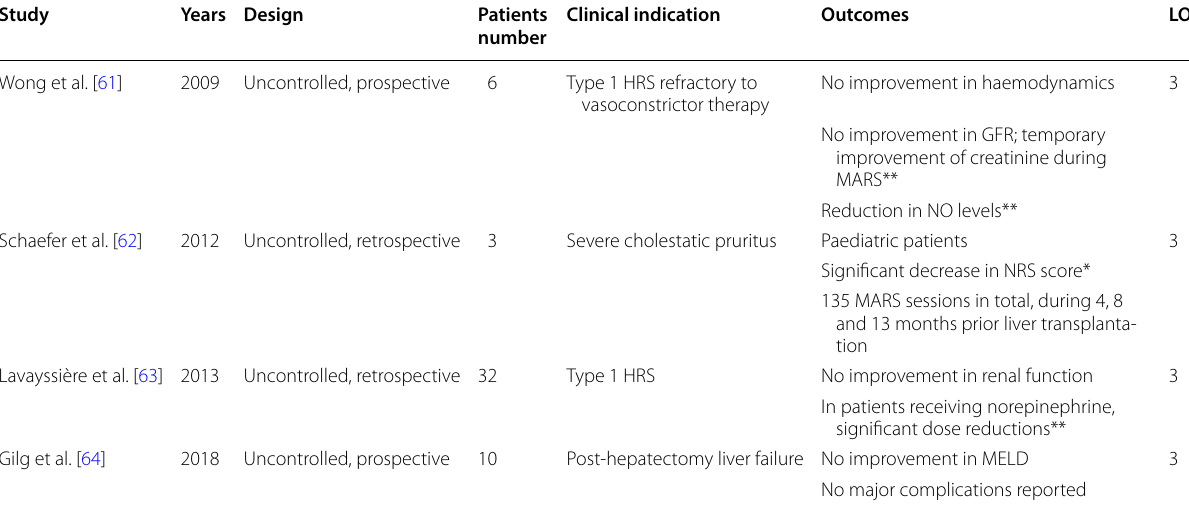
LOE level of evidence, determined using the strength of recommendation taxonomy (SORT) criteria [50], HRS hepatorenal syndrome, GFR glomerular filtration rate, NO nitric oxide, NRS score numeric rating scale, NRS 0: no pruritus, NRS 10: maximal pruritus, MELD model for end-stage liver disease * p <